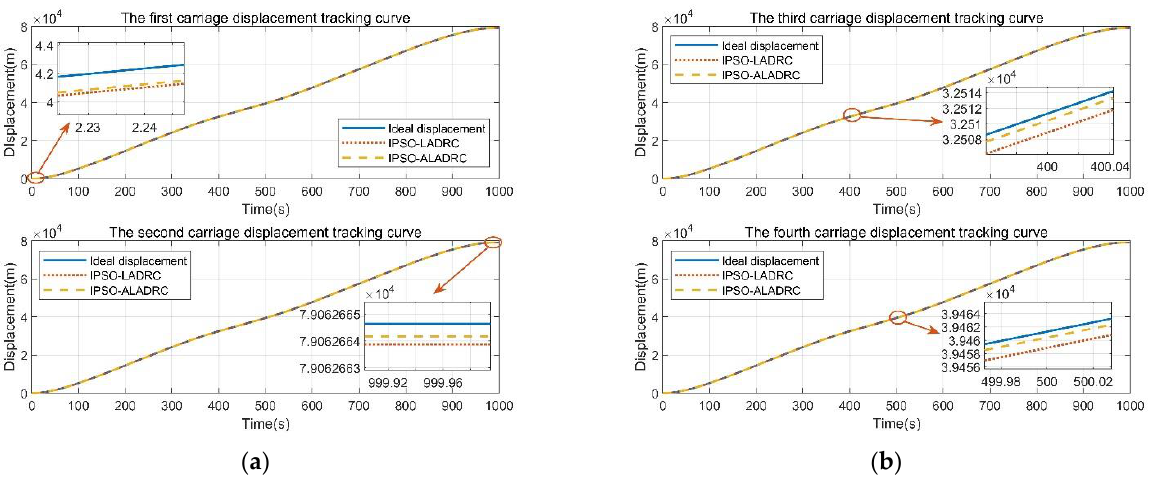
Figure 8. Displacement tracking curve of the four carriages: ( a ) Displacement tracking curve of the first two carriages; ( b ) Displacement tracking curve of the last two carriages.